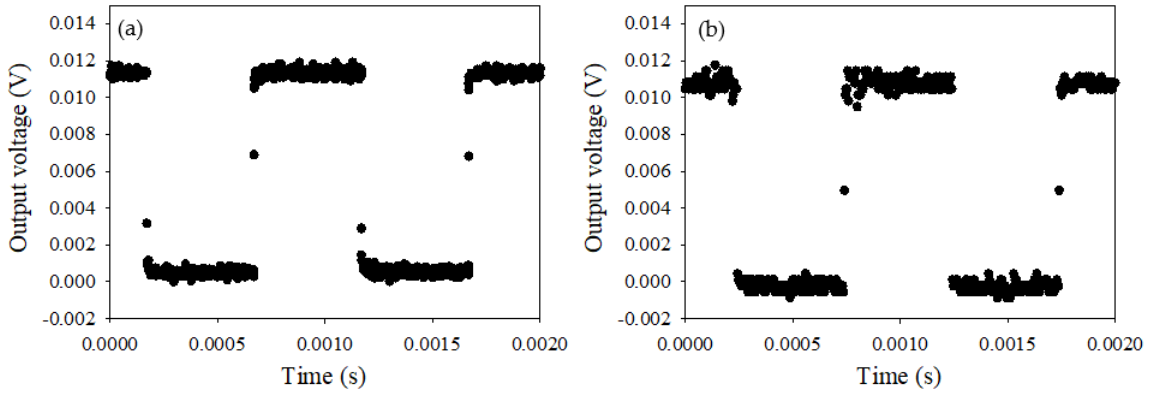
Figure 4. Response time assessment of the IRT with a 870 nm LED pulsed with a 1 kHz square wave, measured by ( a ) the oscilloscope ( b ) the CompactRio acquisition